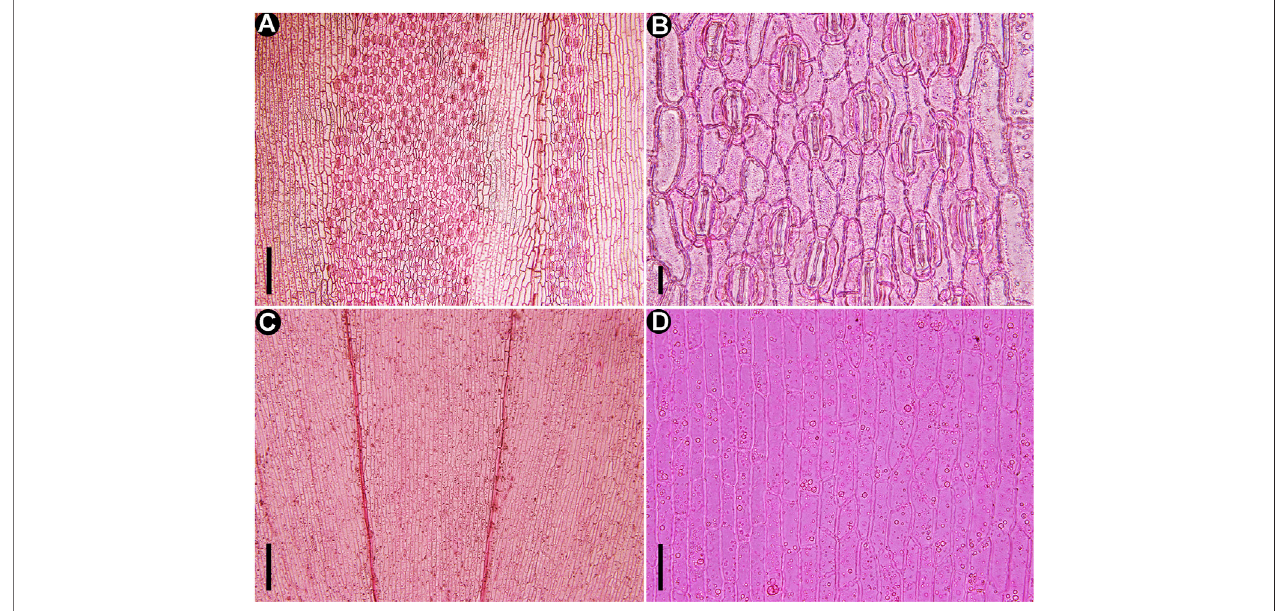
FIGURE 6 | Cuticles of extant Fokienia hodginsii (Dunn) Henry et Thomas, LM. (A) The stomatal distribution on the abaxial surfaces of lateral (left) and facial (right) leaves on the underside of shoot. (B) Enlargement of lateral leaf stomatal band in (A) showing densely arranged stomata sharing subsidiary cells. (C) Cuticles of lateral and facial leaves on the upper surface of a shoot. (D) Enlargement of the epidermal cells in (C) . Scale bars for (A, C) (cid:1) 200 μ m, (B) (cid:1) 20 μ m, (D) (cid:1) 50 μ m.